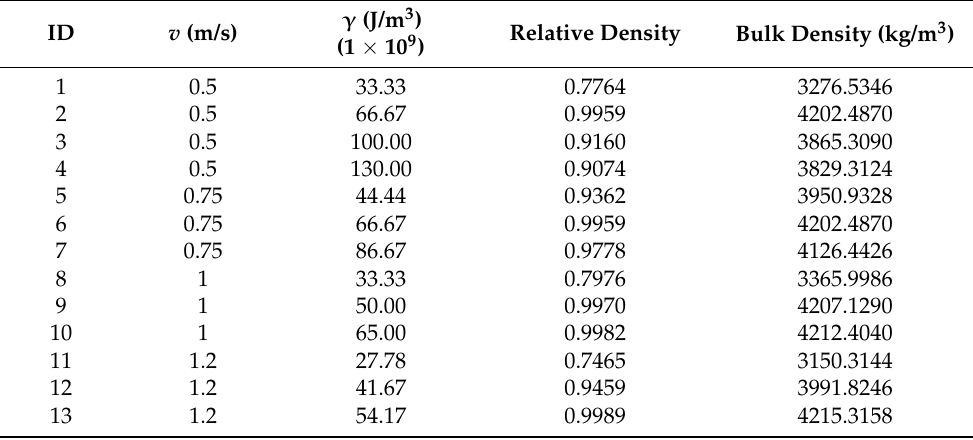
Table 12. Parameter values used to AM Ti6Al4V alloy samples. Experimental data taken from